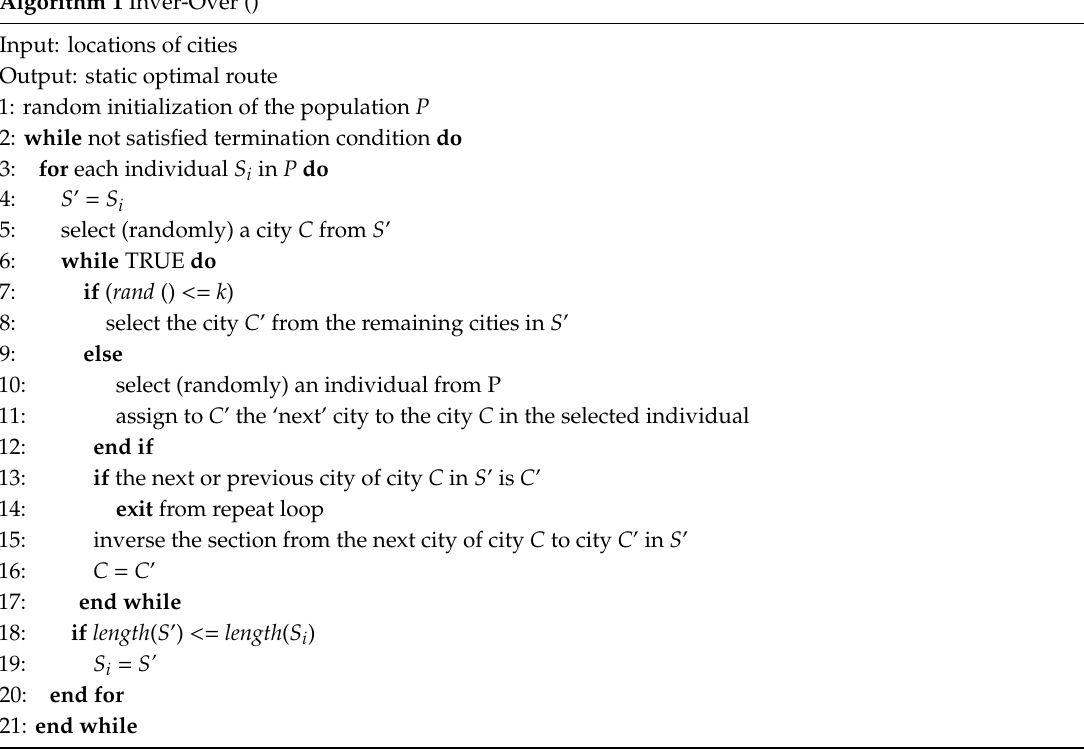
Algorithm 1 Inver-Over